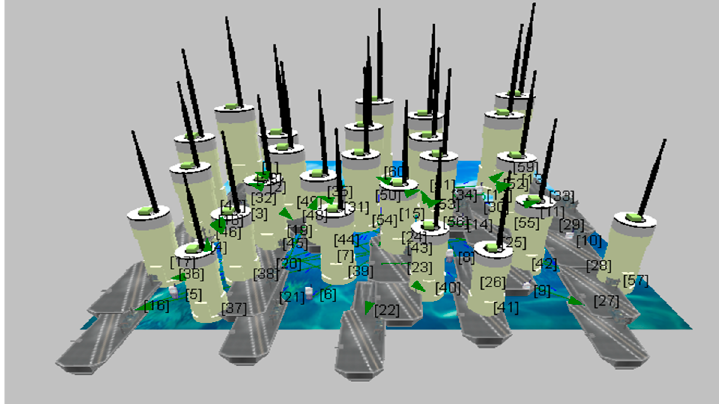
Figure 2. 3D- Visualization of underwater wireless communication.